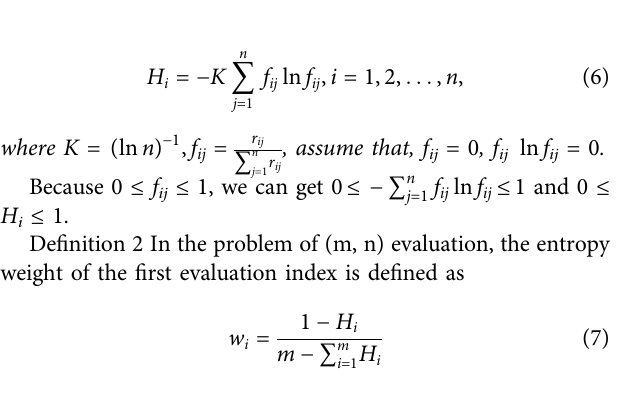
FIGURE 9 | The distribution of closness centrality of the TOA Network: Plot the number of the number of closness centrality on the vertical Y -axis against closness centrality on the horizontal x -axis.